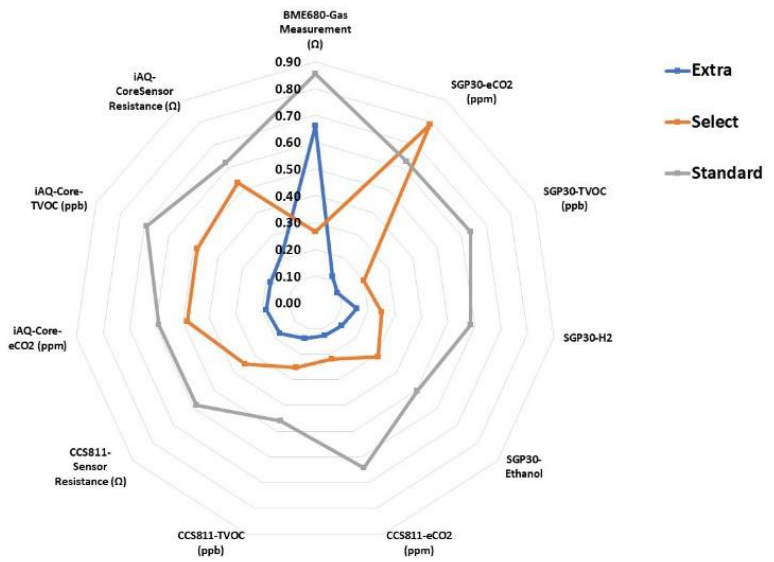
Figure 3. Radial plot of the sensor ´ s responses to Californian-style black olives stuffed with hydro- Figure 3. Radial plot of the sensor´s responses to Californian-style black olives stuffed with hydro- colloids. BME680: gas measurement ( Ω ); SGP30: eCO 2 (ppm), organic volatile compounds (ppb), colloids. BME680: gas measurement (Ω); SGP30: eCO 2 (ppm), organic volatile compounds (ppb), H 2 H 2 and ethanol; CCS811: eCO 2 (ppm), organic volatile compounds (ppb) and sensor resistance ( Ω ); and ethanol; CCS811: eCO 2 (ppm), organic volatile compounds (ppb) and sensor resistance (Ω); iAQ-Core: eCO 2 (ppm), organic volatile compounds (ppb) and sensor resistance ( Ω ). iAQ-Core: eCO 2 (ppm), organic volatile compounds (ppb) and sensor resistance (Ω). Figure 3. Radial plot of the sensor´s responses to Californian-style black olives stuffed with hydro- E-nose to the different samples from each category could be distinguished from each colloids. BME680: gas measurement (Ω); SGP30: eCO 2 (ppm), organic volatile compounds (ppb), H 2 and ethanol; CCS811: eCO 2 (ppm), organic volatile compounds (ppb) and sensor resistance (Ω); iAQ-Core: eCO 2 (ppm), organic volatile compounds (ppb) and sensor resistance (Ω).